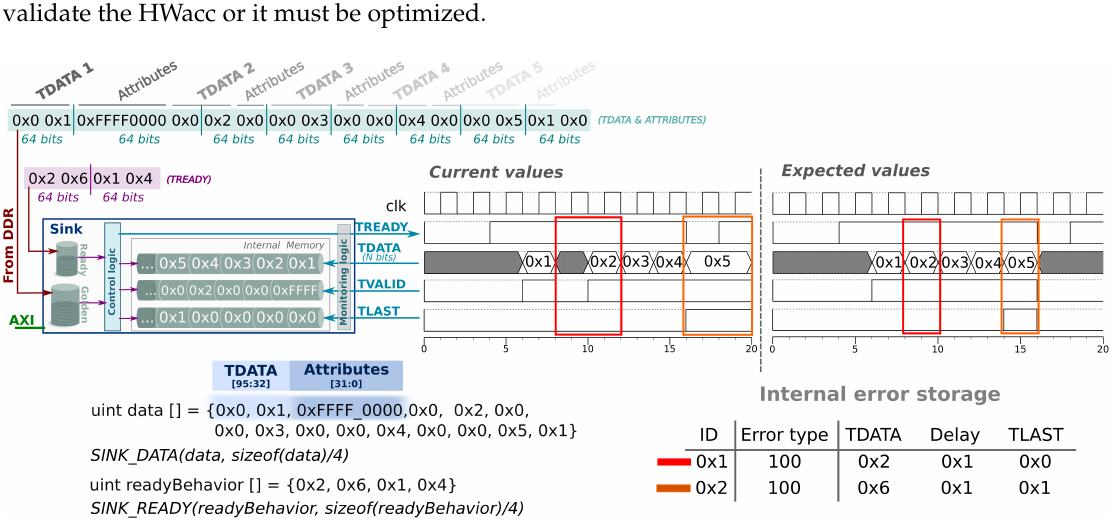
Figure 5. Block and timing diagram example of sink